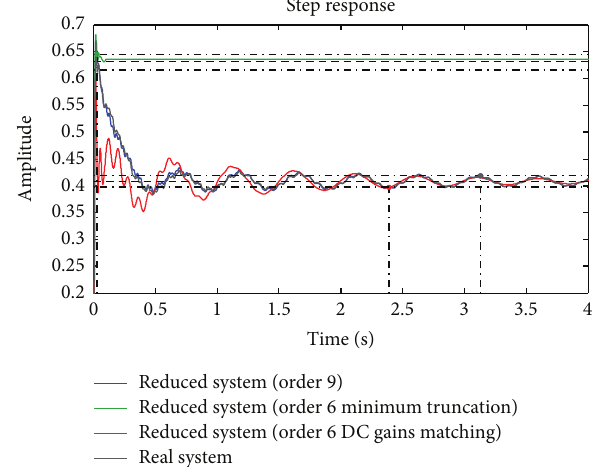
Figure 5: Comparison of frequency responses for reduced order models.